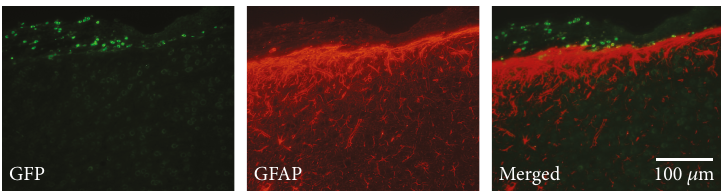
Figure 7: Immunohistochemistry for GFP and GFAP. Panels show fl uorescent photomicrographs around the brain surface where the RCP sponge contacted 5 weeks posttransplantation in the BMSC/sca ff old groups. Green: GFP; red: GFAP. Scale bars: 100 μ